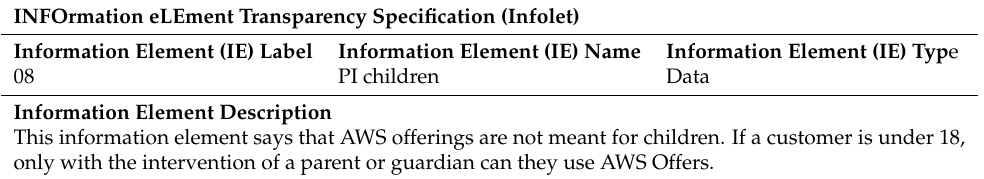
Table A5. AWS: Infolet for PI